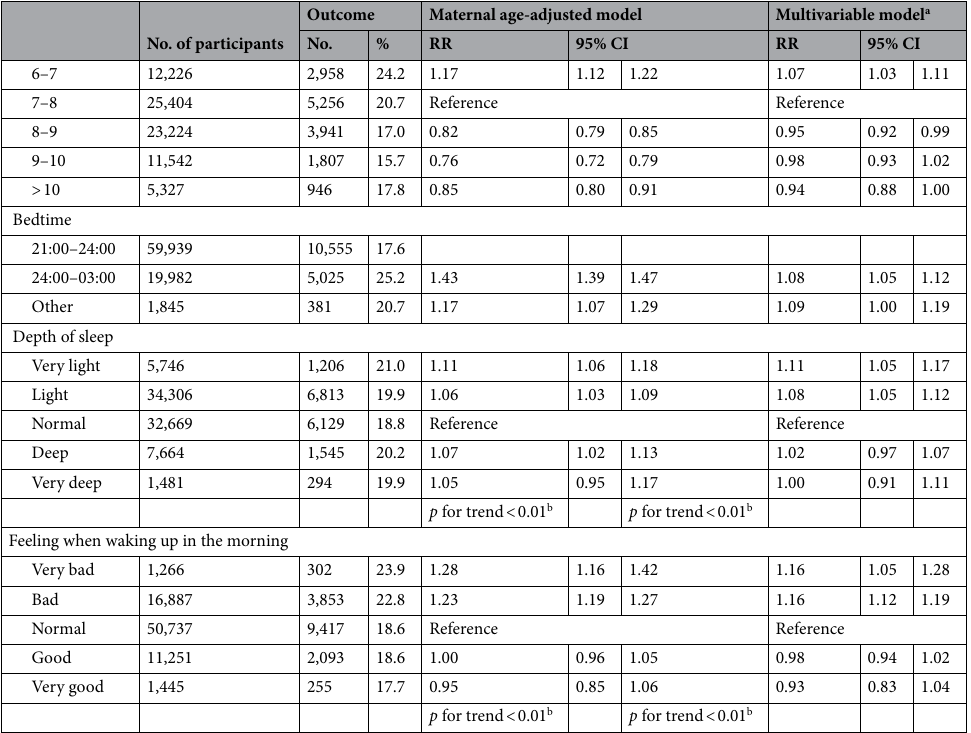
Table 7. Association between sleep during pregnancy and neonatal temperament in the Japan Environment and Children’s Study (2011–2014). CI, confidence interval; RR, relative risk. a Adjusted for maternal age at delivery, smoking habits, alcohol consumption, pre-pregnancy body mass index, gestational age at birth, parity, infertility treatment, infant sex, small for gestational age, type of delivery, and postpartum depressive symptoms. b Linear trend in the association was tested by assignment of ordinal variables for the five categories.